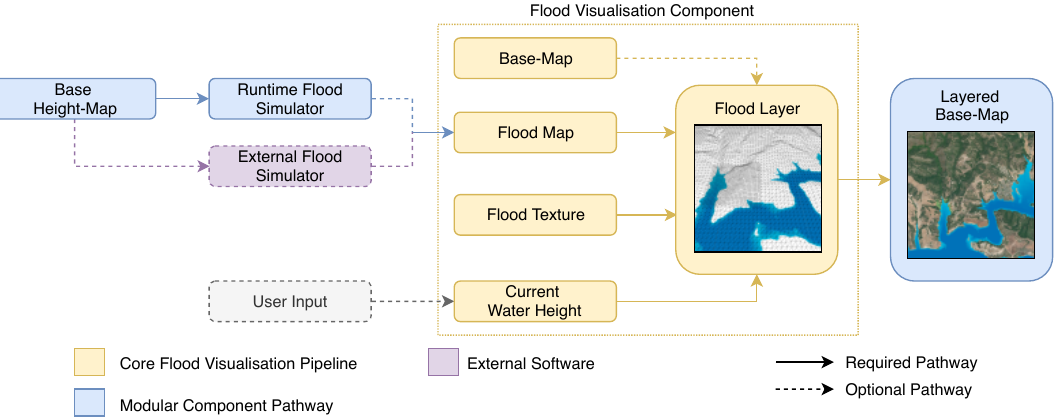
Figure 2. The Flood Visualisation pipeline. The Flood Visualisation component compares the flood map, flood height and base map to create a flood layer to augment the base map before final